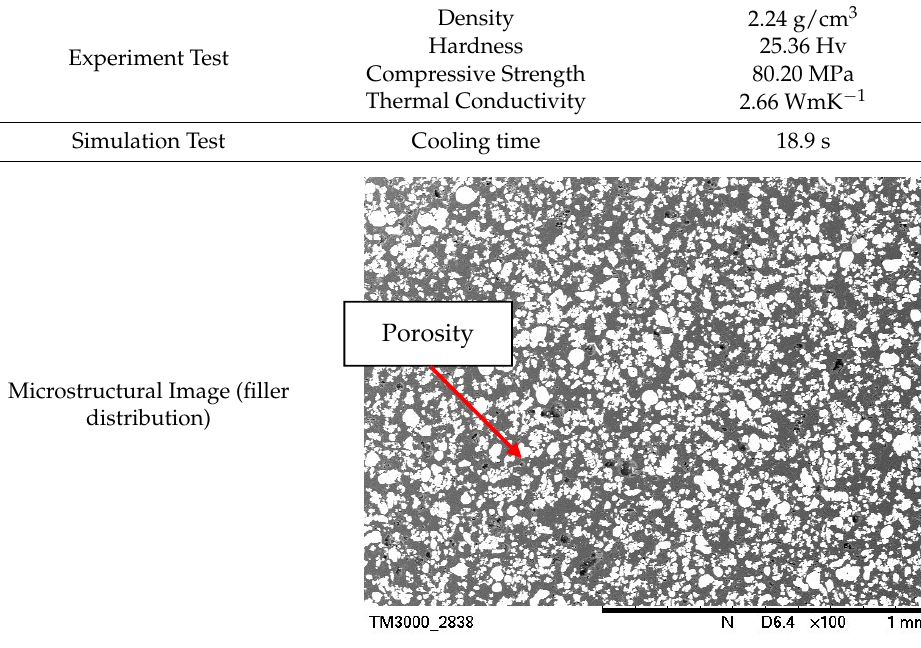
Table 13. Material properties of MEC mold insert (60% copper filler).